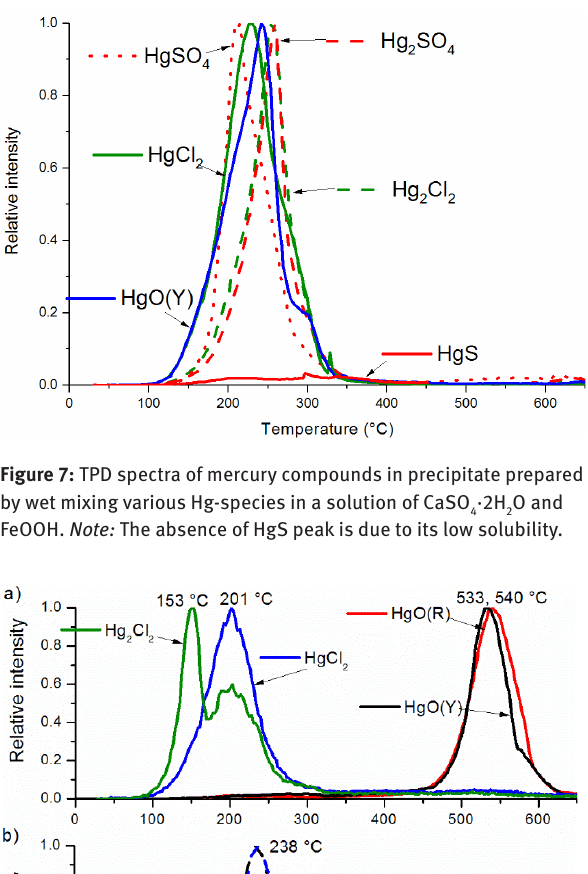
Figure 8: a) TPD spectra of Hg with dry FeOOH and b) TPD spectra of HgCl prepared by wet mixing of Hg-species in a solution of